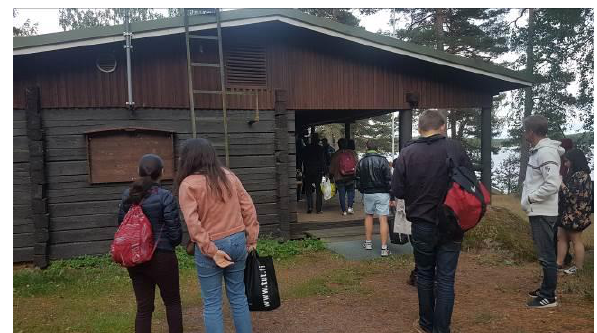
Figure 6. Evening Sauna in the military recreational area of Mäntlahti